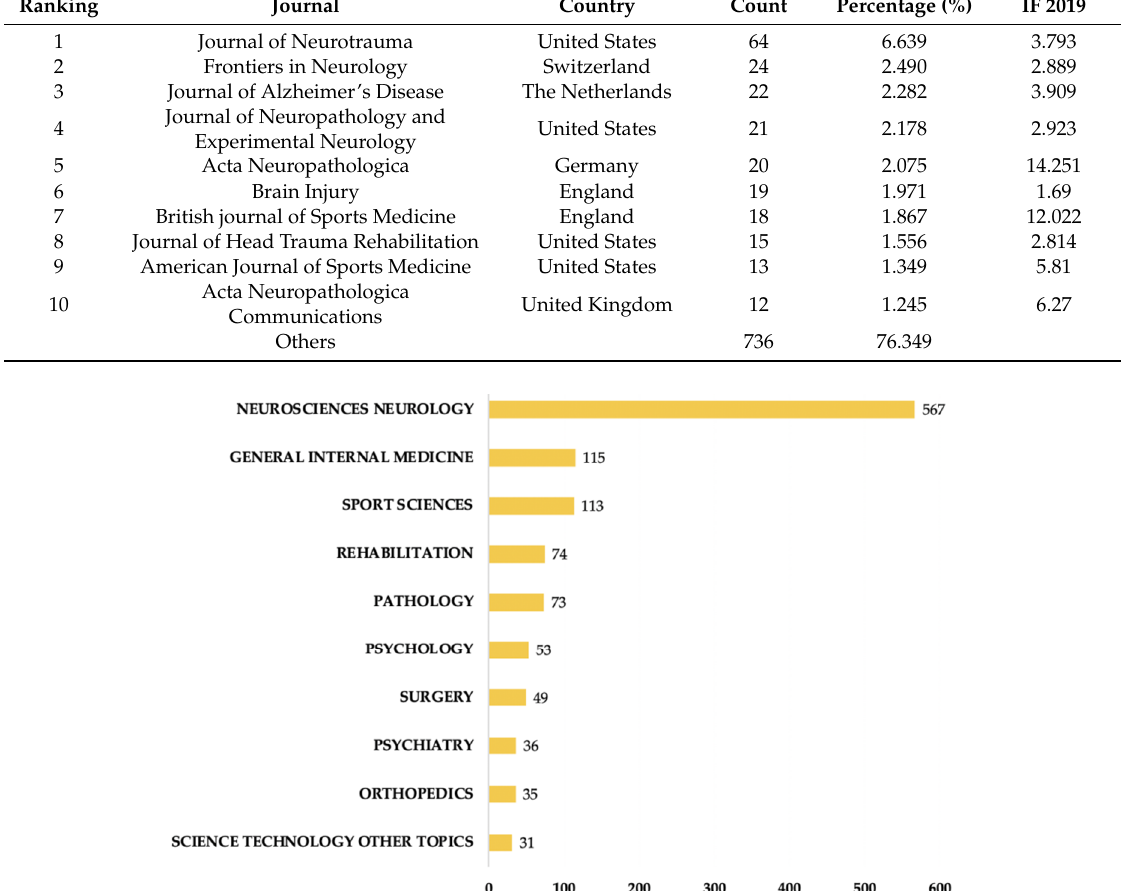
Figure 4. Ranking of top 10 active research areas on CTE from 1999 to 2019.